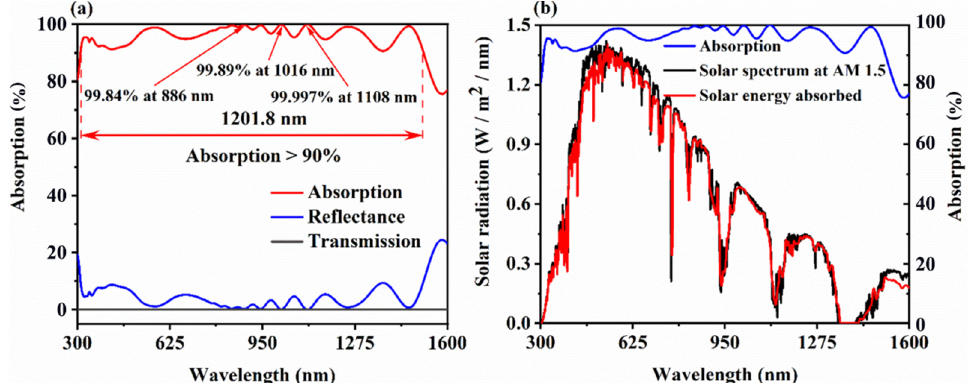
Figure 5. ( a ) Absorption, reflection and transmission of the device in the wavelength range of 300–1600. ( b ) Weighted absorption at AM1.5.